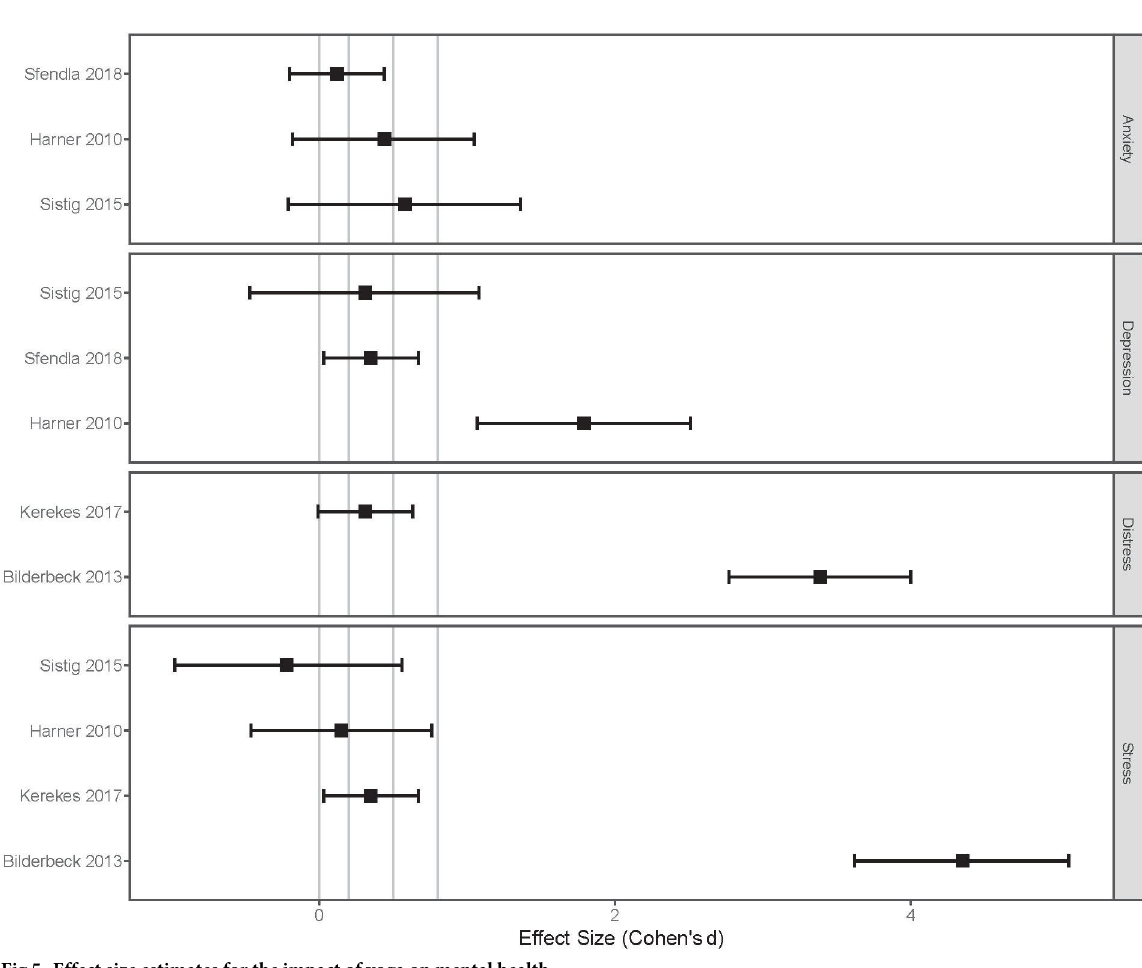
Fig 5. Effect size estimates for the impact of yoga on mental